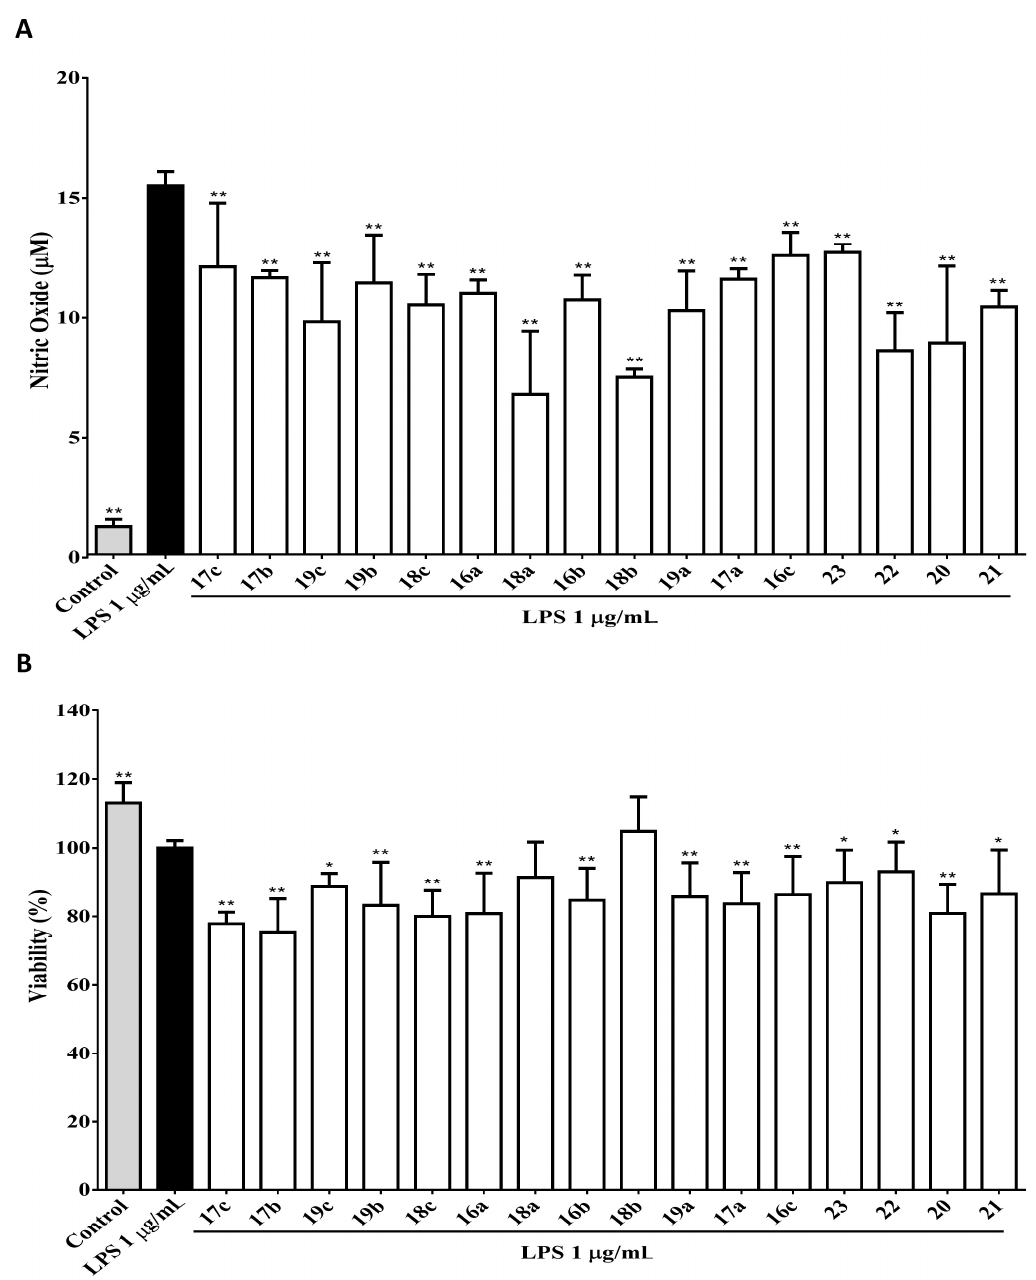
Figure 2. Effects of 2- substituted 3-arylquinoline derivatives on NO production and cell viability by